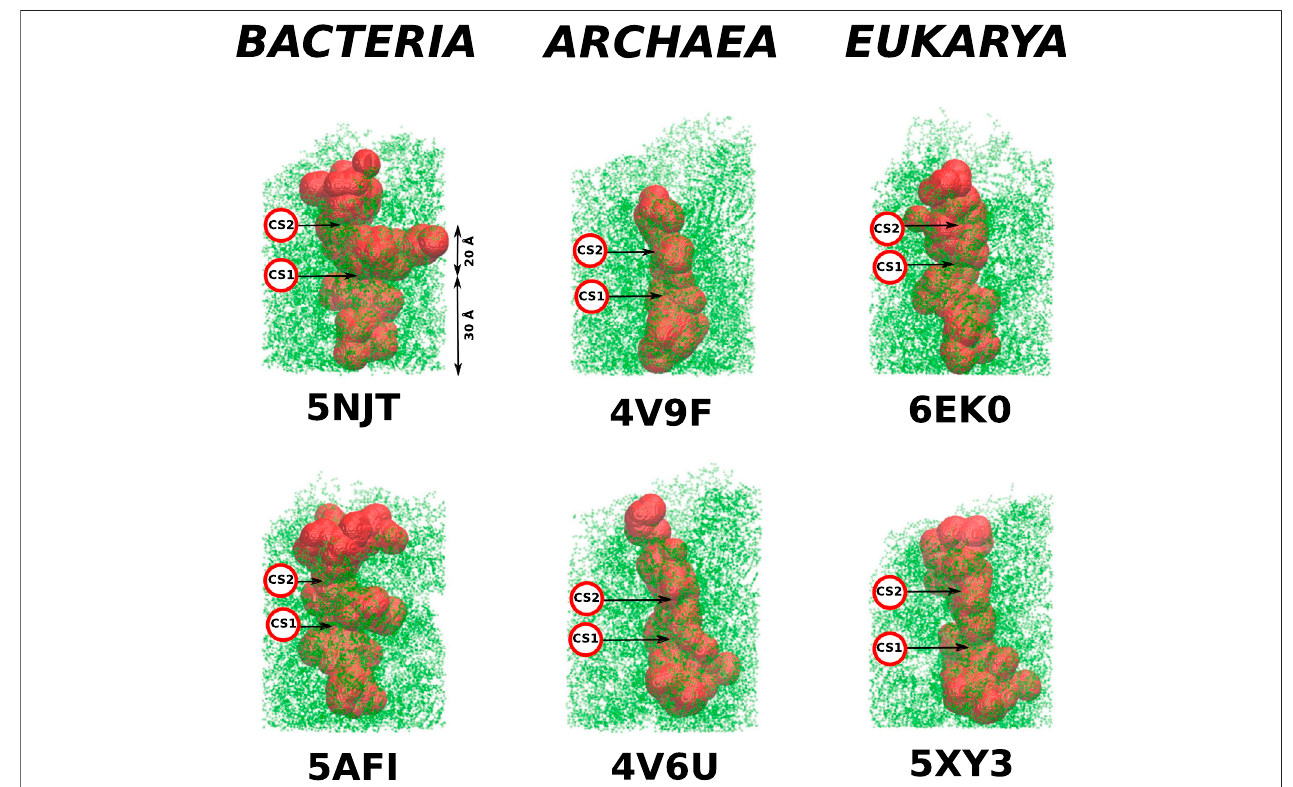
FIGURE3| Structuresofthecylindricalcut-outsaroundtheribosomalexittunnelsfromthethreedifferentdomainsoflife.Eachofthesixpanelsshowstheall-atom representation of the cylinder. The colors are meant just to generate a sense of perspective. The structures shown below the main picture represents the very exit of the cylinder. Up to fi ve colors are used to indicate the vertical positions. The ball-like structure on the right of the cylinder represents the top view of the exit